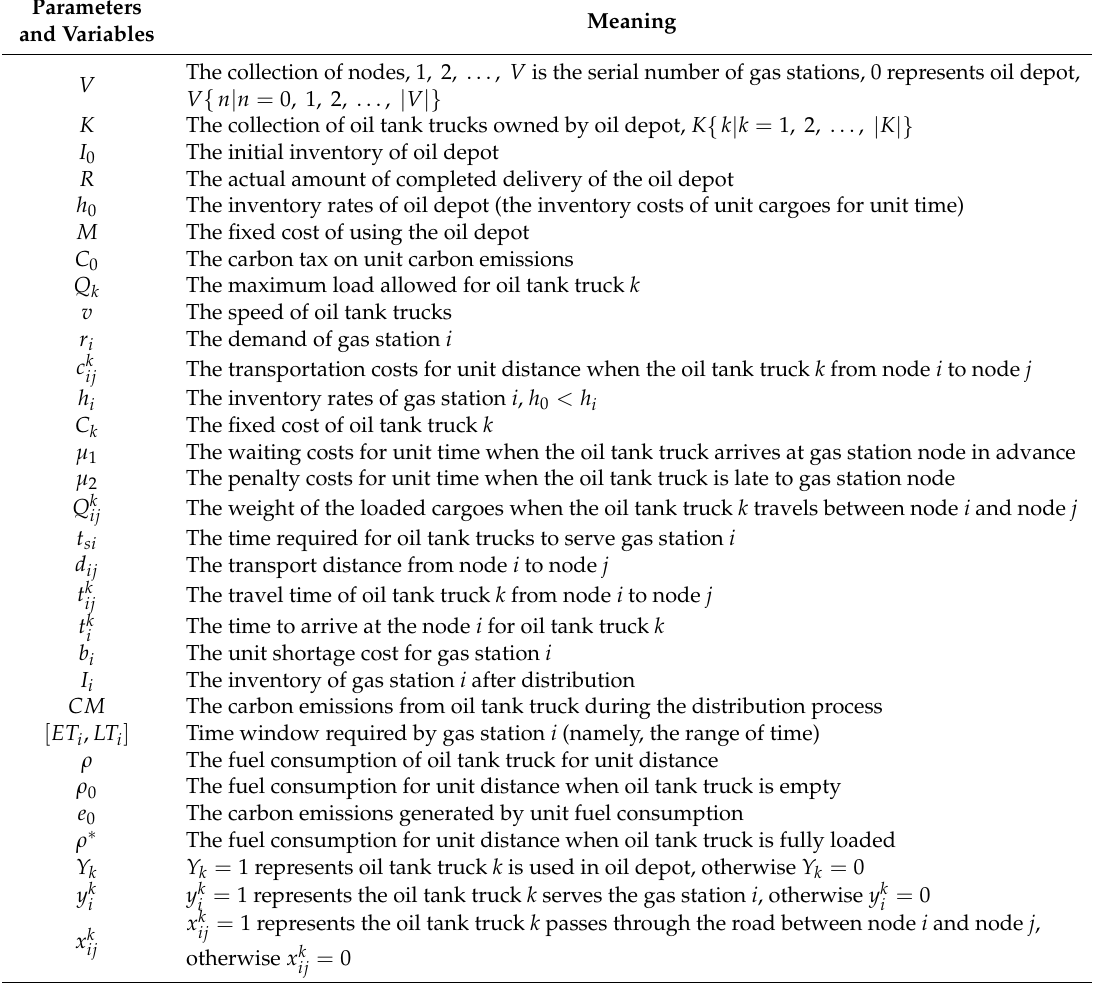
Table 1. The meaning of parameters and